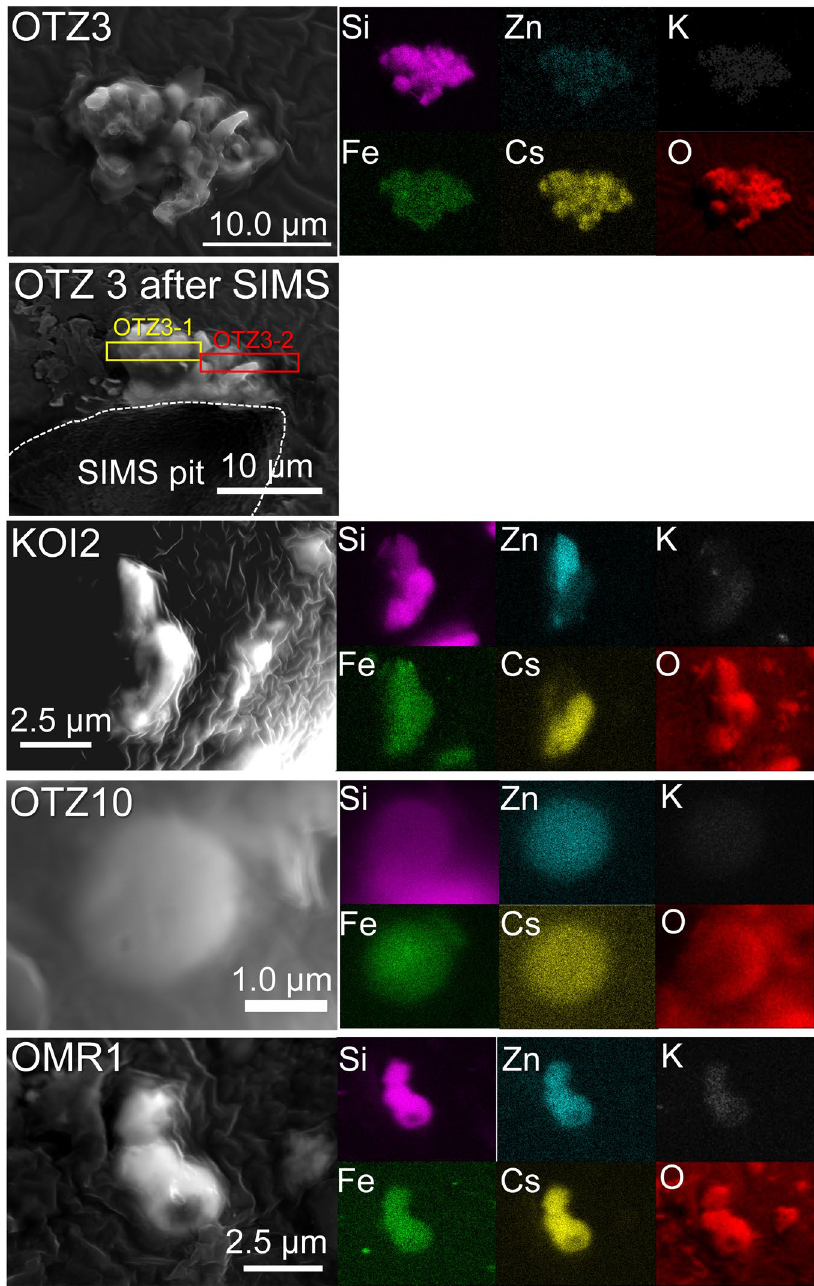
Figure 2. SEM images of CsMPs associated with the elemental